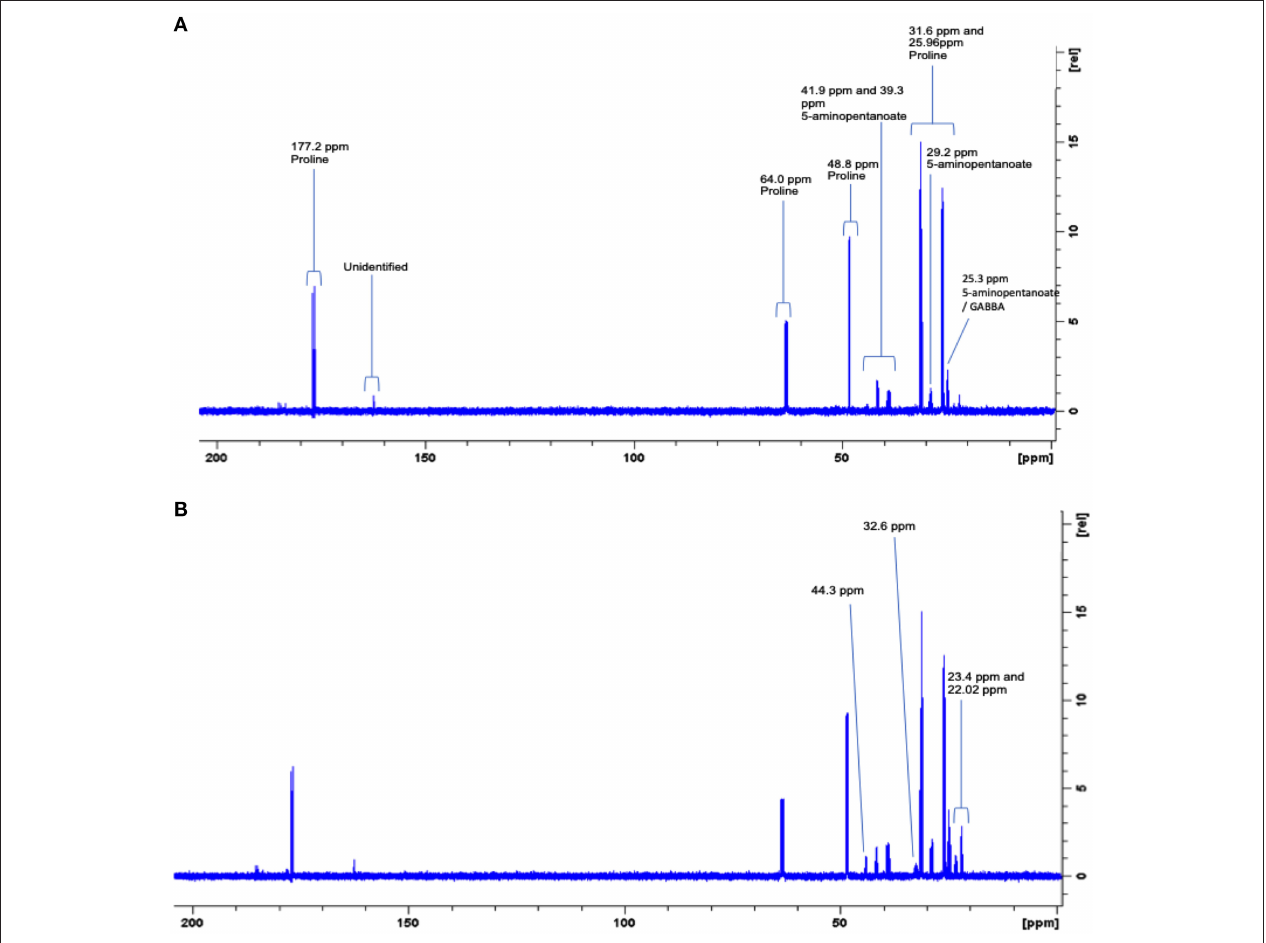
FIGURE 5 | Representative full 600 MHz 1D C 13 NMR spectra for one day 4 (A) and day 7 (B) 10mM C 13 -labeled proline supplemented biofilm spent saliva. Identification and chemical shift (ppm) of metabolite peaks are labeled in (A) and additional peaks identified at day 7 are labeled in (B)